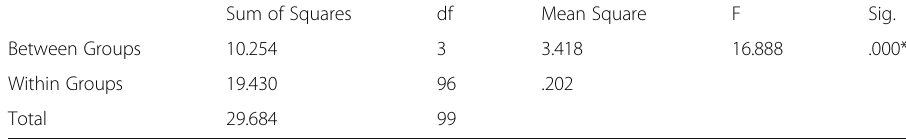
Table 4 The result of ANOVA to compare participants ’ perceptions across teaching experience groups